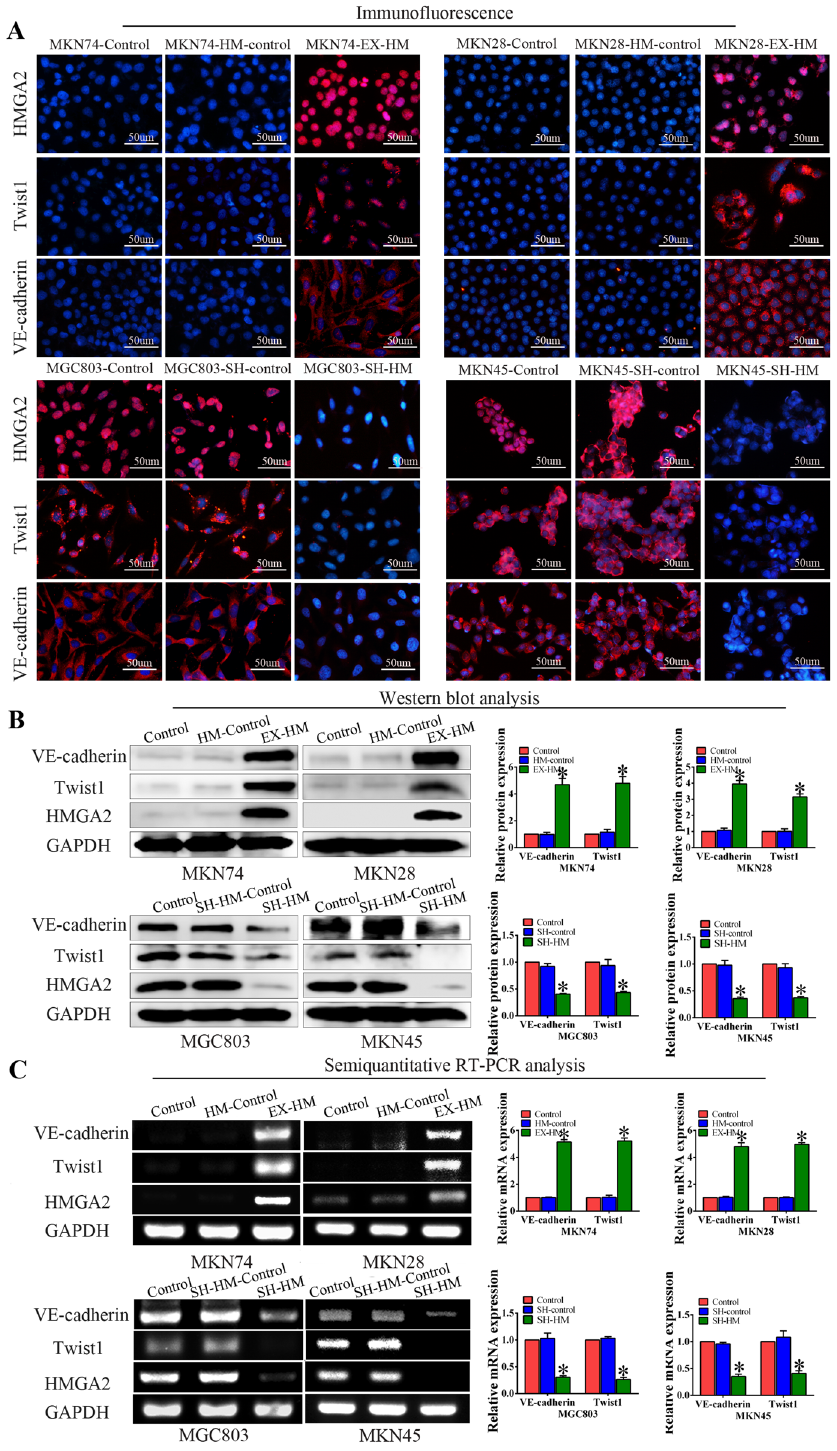
Figure 3. HMGA2 upregulates Twist1 and VE-cadherin expression in GC cell lines. ( A ) Immunofluorescence staining. Overexpression of HMGA2 increased the expression of Twist1 and VE-cadherin, while HMGA2 silencing inhibited Twist1 and VE-cadherin expression (bar, 50 um). Western blot ( B ) and semi-quantitative RT-PCR ( C ) were performed to analyze the expression of Twist1 and VE-cadherin in GC cells ( * P < 0.05). The results show that Overexpression HMGA2 induced upregulation of Twist1 and VE-cadherin expression, the inverse change were obtained with the knockdown of